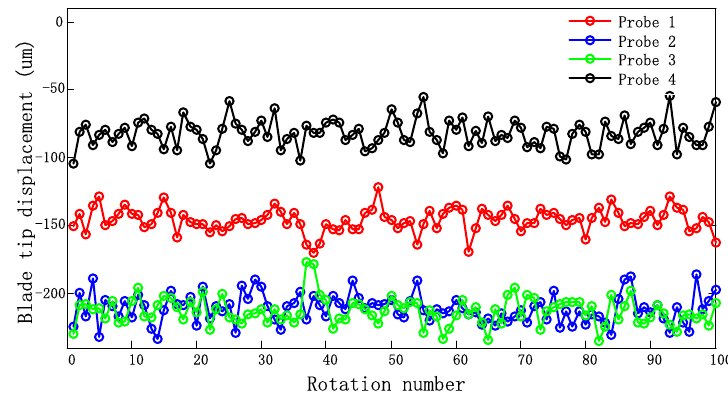
Figure 15. Signals of blade tip displacement.